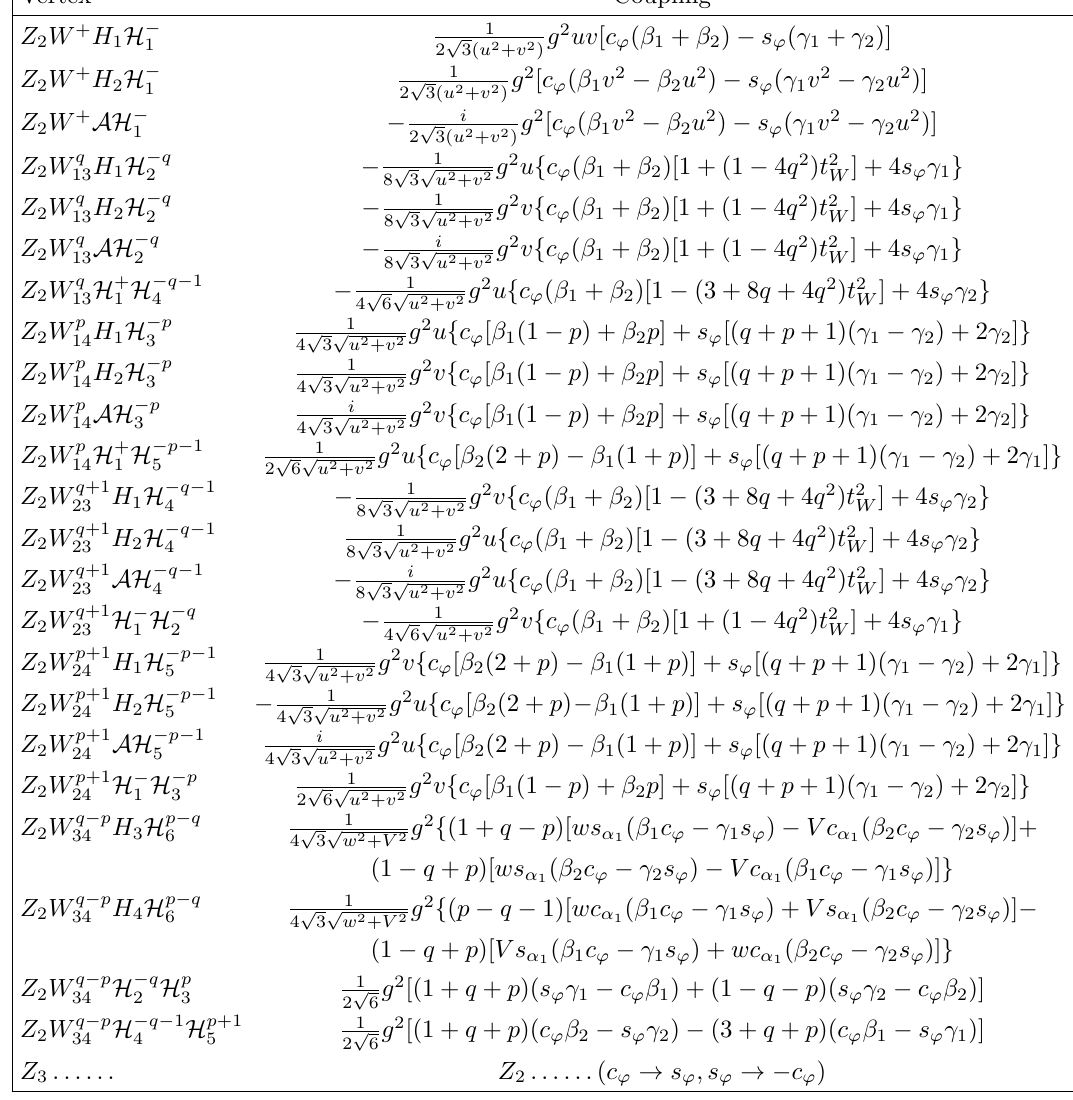
Table 16 . The interactions of a neutral and a charged gauge boson with two scalars (Continued).